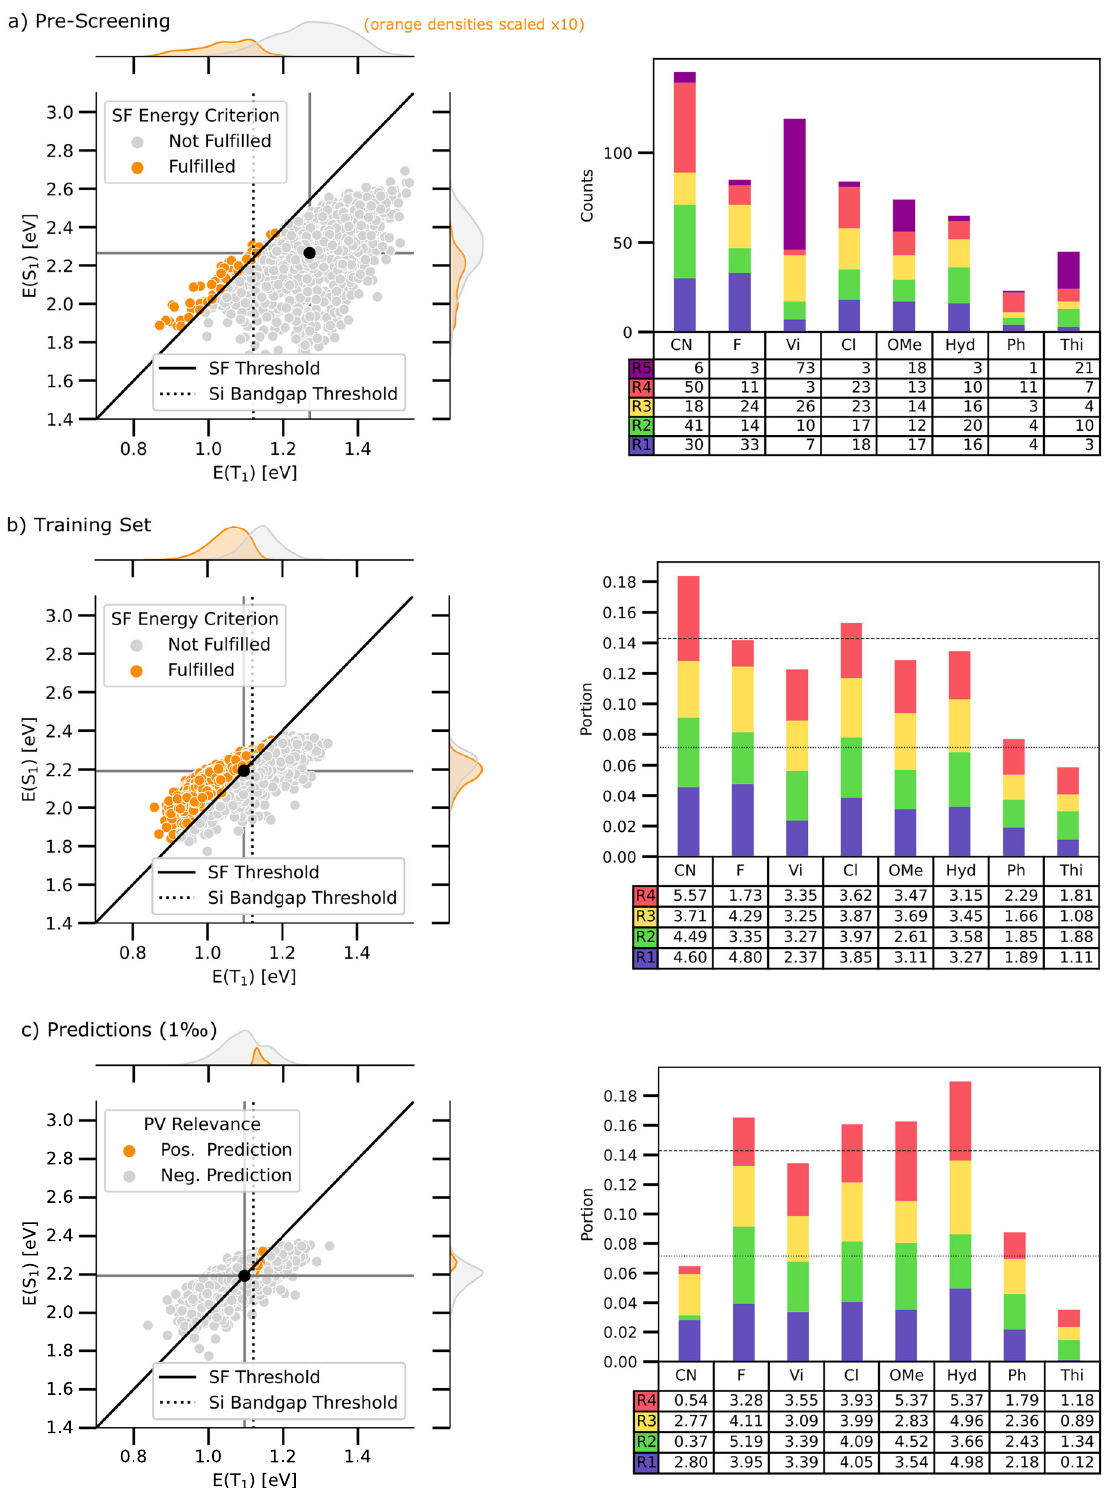
Fig. 1 Excitation energy distributions (left) and chemical compositions (right) of highlighted orange samples from respective distribution. a , b and c ; data from pre-screening, training and predictions, respectively. For the predictions, one per mille of random data is shown in the distribution while the histogram covers the full data. Solid and dashed black lines show onsets for SF and the Si band-gap (1.12 eV). Mean energies ~ E ð S 1 Þ and ~ E ð T 1 Þ (black dot) separate the data into useful quadrants (grey